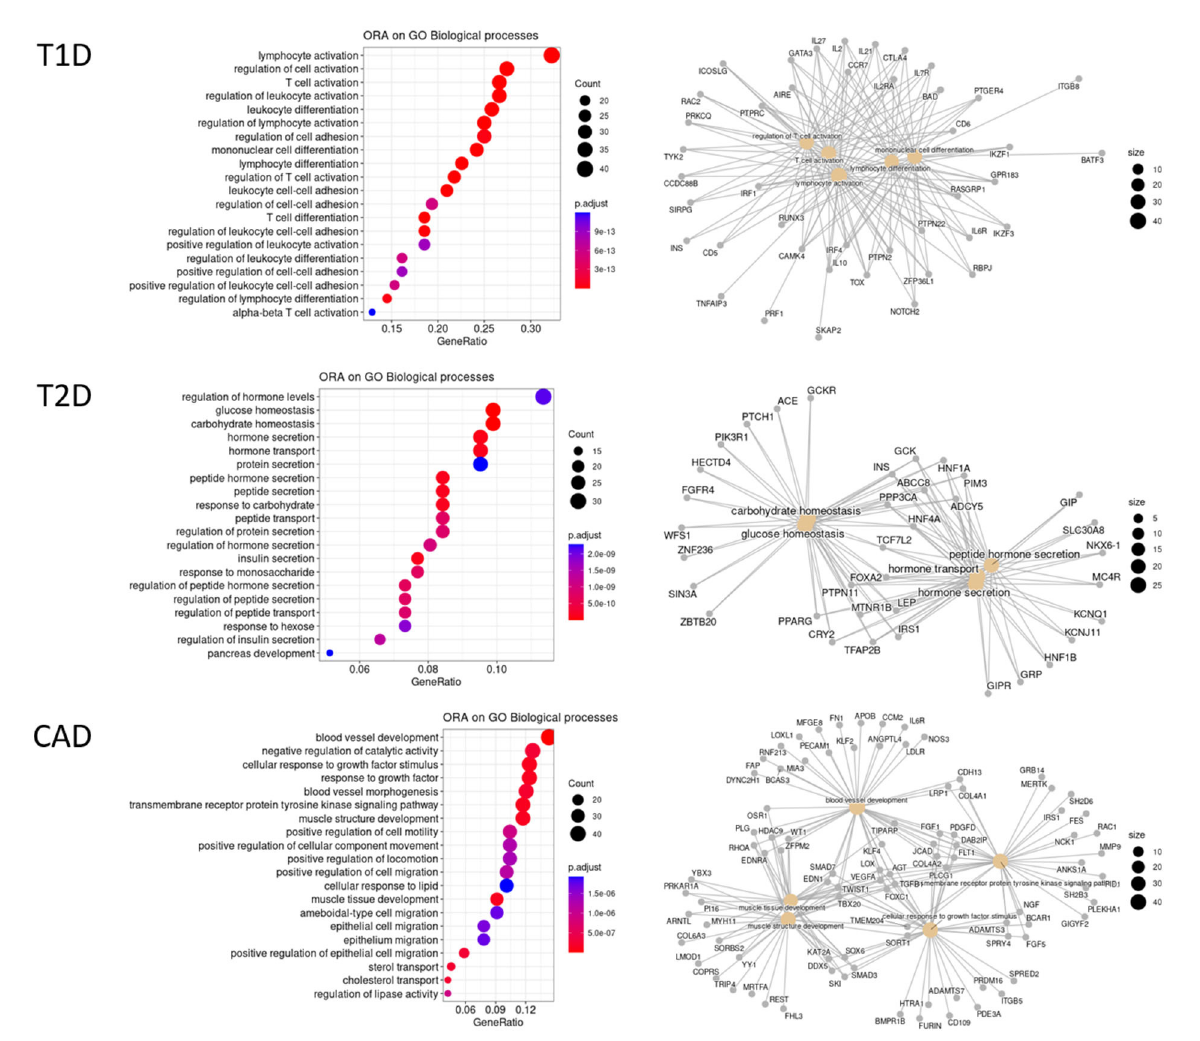
FIGURE3 Over-representation analysis (ORA) of GWAS gene annotations for T1D, T2D, and CAD. GWAS association signals most often fall in non-coding regions. Thus, candidate genes are selected on the basis of their proximity to the GWAS lead SNPs or using integrative approaches. For some hits, several genes are considered as candidates. A total of 131 T1D candidate genes outside the MHC were collected from Onengut et al. (104), Chiou et al. (105), and Robertson et al. (106) at GWAS significant hits at a genome-wide significance. For T2D, 288 genes were considered as the most credible ones from Mahajan et al. (107) using the trans-ethnic significance threshold. The list of 347 CAD genes was collected from Erdman et al. (108) and Koyama et al. (109) at genome-wide significance threshold. HGNC official gene names were used. An ORA on these 3 datasets was conducted independently against the different GO terms and KEGG pathways with clusterProfiler R package. Only the top 20 significant enrichments at a FDR of 10% biological processes of GO are displayed here. Left panels are dotplots showing each top 20 GO term with the enrichment gene ratio (X-axis). A color code indicates the level of significance, while the circle size represents the number of genes found in the query dataset for each given GO term. Right panels are cnetplot (Gene Concept Networks) depicting the relationships between genes and GO